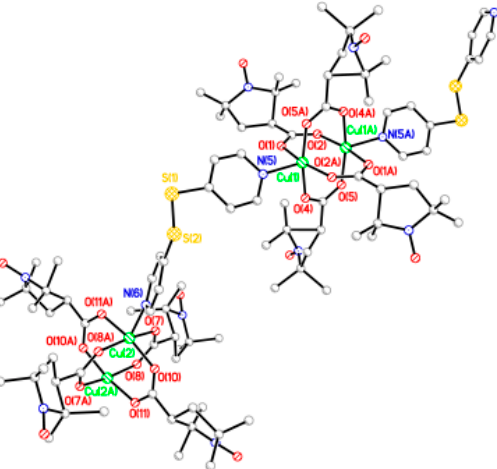
Figure 5. Perspective view of [Cu 2 (catempo) 4 (H 2 O) 2 ] ( 2 ). Hydrogen atoms are omitted for clarity.